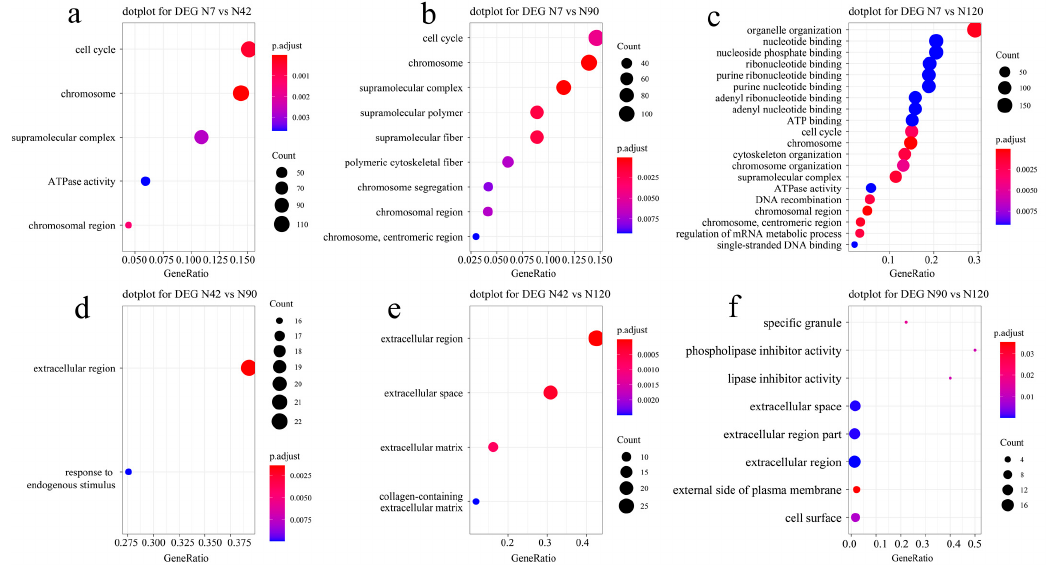
Figure 3. Dot plot of DEGs enriched by the GO database. ( a ) Dot plot of DEGs in the N7 vs. N42 comparison group; ( b ) dot plot of DEGs in the N7 vs. N90 comparison group; ( c ) dot plot of DEGs in the N7 vs. N120 comparison group; ( d ) dot plot of DEGs in the N42 vs. N90 comparison group; ( e ) dot plot of DEGs in the N42 and N120 comparison group; and ( f ) dot plot of DEGs in the N90 vs. N120 comparison group.